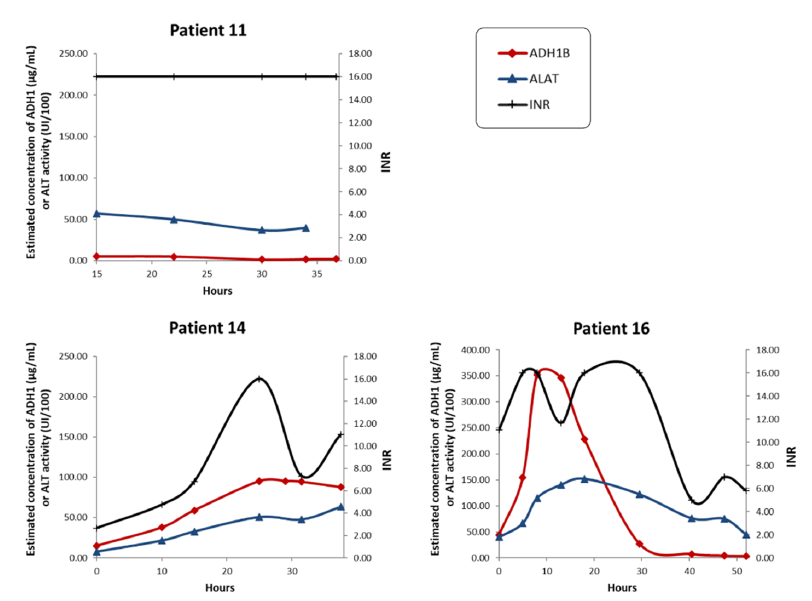
Figure 4. Time-dependent changes in liver injury biomarkers in patients with acetaminophen-induced ALI/ALF who received a liver transplant. Biological profiles of ALI/ALF patients before liver transplantation. ADH1B serum concentration was determined via quantitative LC–SRM. The INR is reported as an indicator of coagulation defects. Serum ALT activity is also indicated for comparison. Data points were connected using a smoothed line.